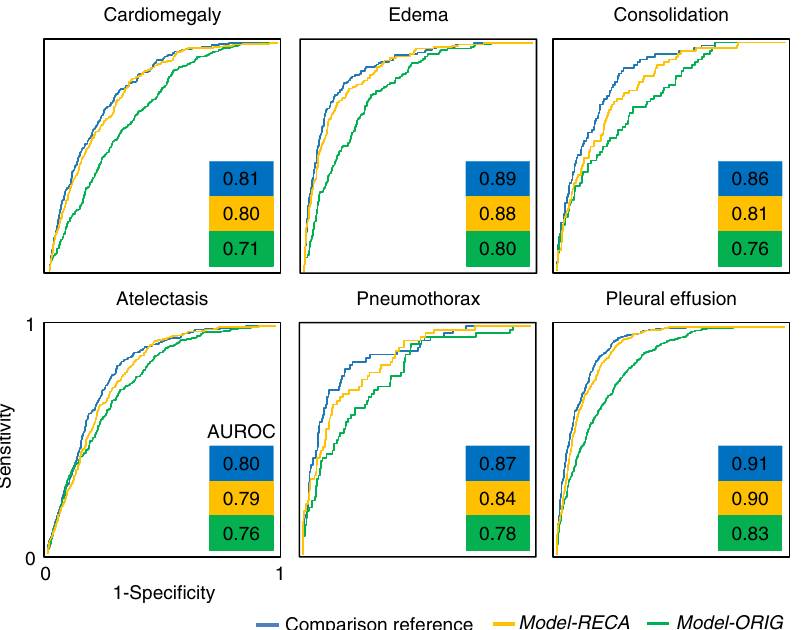
Fig. 3 ROC curves for detecting cardiomegaly, edema, consolidation, atelectasis, pneumothorax, and pleural effusion observed in CXRs and CXR photographs. Blue lines show the ROC curves using the uncalibrated model on original CXRs. The yellow and green lines show the results of interpreting CXR photographs using the uncalibrated model ( Model-ORIG ) and recalibrated model ( Model-RECA ), respectively. The AUC of Model-ORIG is signi fi cantly greater than that of Model-RECA for each disease ( p <